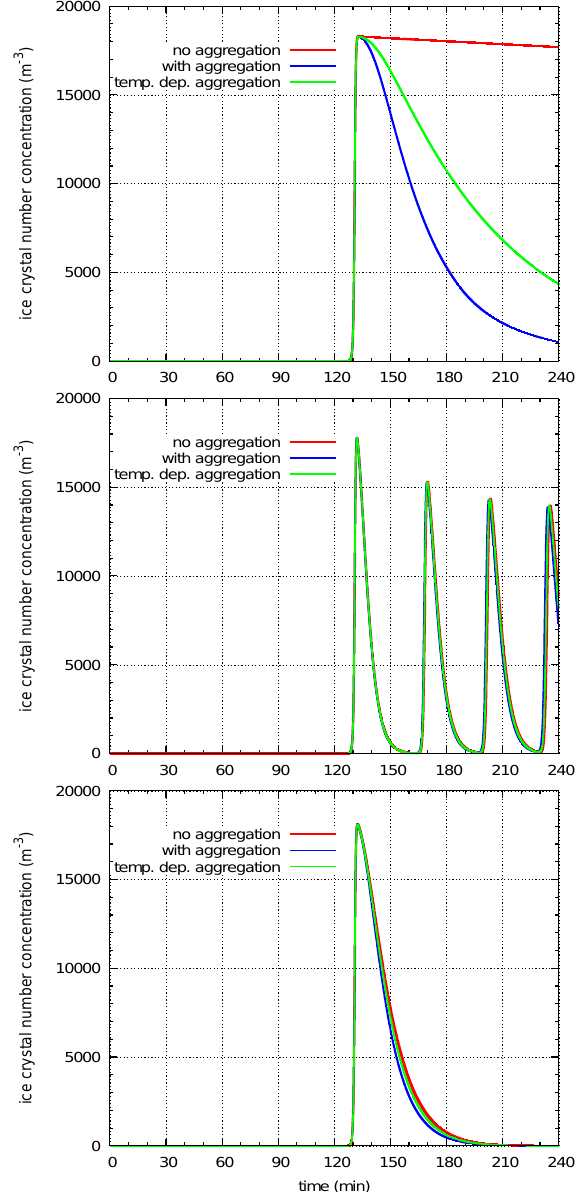
Fig. 6. Ice crystal number concentration as a function of time for dif- ferent sedimentation factors. Top panel: f sed = 1 . 0, i.e. no sedimen- tation, leading to the strongest impact of aggregation; middle panel: f sed = 0 . 5, representing the upper part of a cloud; bottom panel: f sed = 0 . 9, representing the lower part of a cloud. Simulations with- out aggregation are indicated by red lines, simulations including ag- gregation with maximum strength are represented by blue lines and simulations with temperature-dependent aggregation are indicated by green lines. All simulations starts at T = 240K, p = 300hPa and are driven by a constant vertical updraught of w = 0 . 05 ms − 1 .